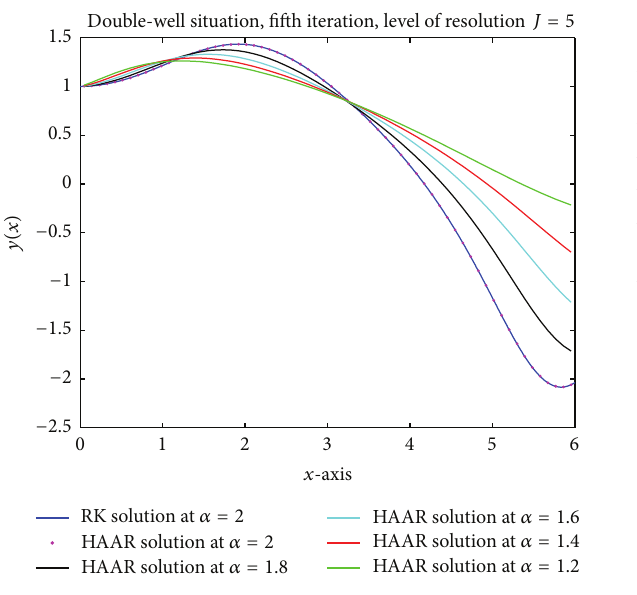
Figure 2: Solution by RK method (RK Solution) at 𝛼 = 2 and solution by Haar wavelet-quasilinearization technique (HAAR Solution) at 𝐽 = 5 and different values of 𝛼 for 𝑎 = −0.5 , 𝑏 = 0.5 , 𝜇 = 0.1 , 𝑓 = 0.5 , and 𝜔 = 0.79 .